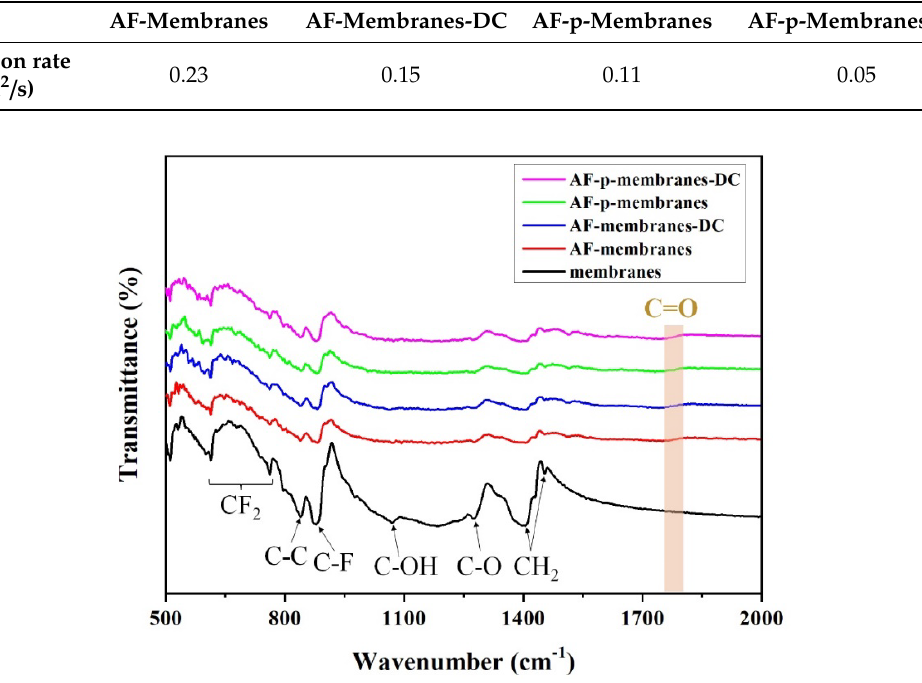
Figure 8. Fourier transform infrared spectroscopy (FT-IR) spectra of the PVDF/CFO membranes.